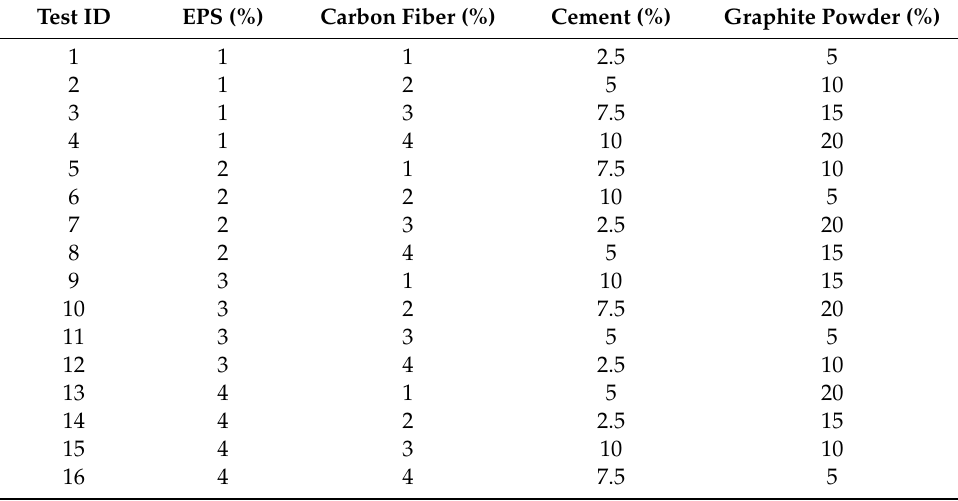
Table 4. Testing program for the specimens with di ff erent mix